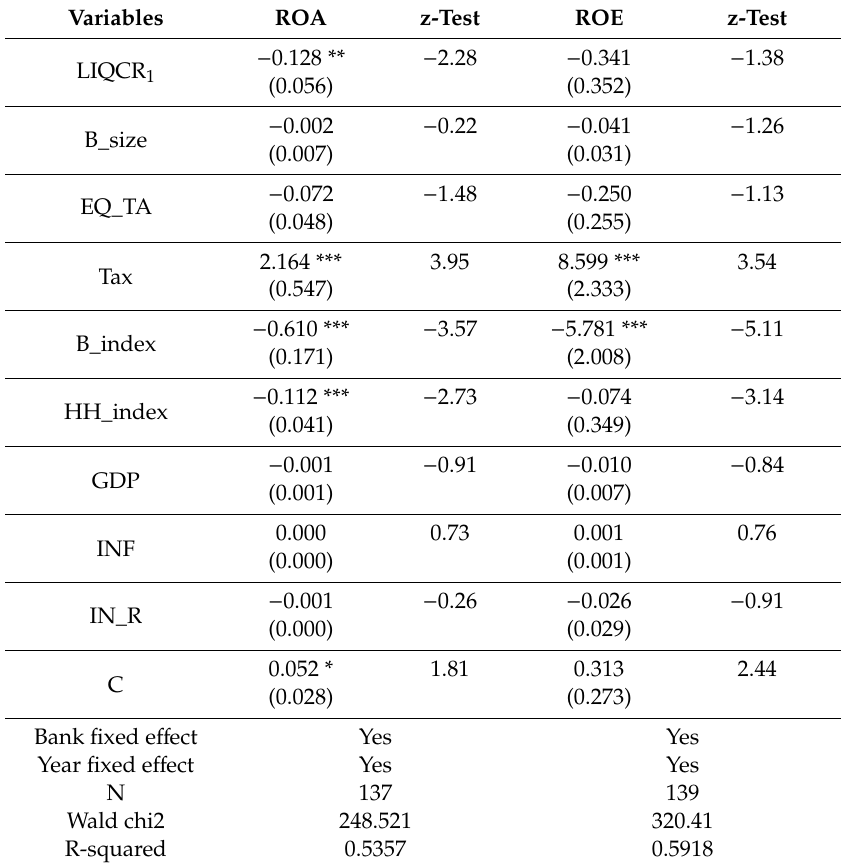
Table 11. Liquidity creation and bank profitability—excluding CBS (own-state bank). Variables ROA z-Test ROE z-Test LIQCR